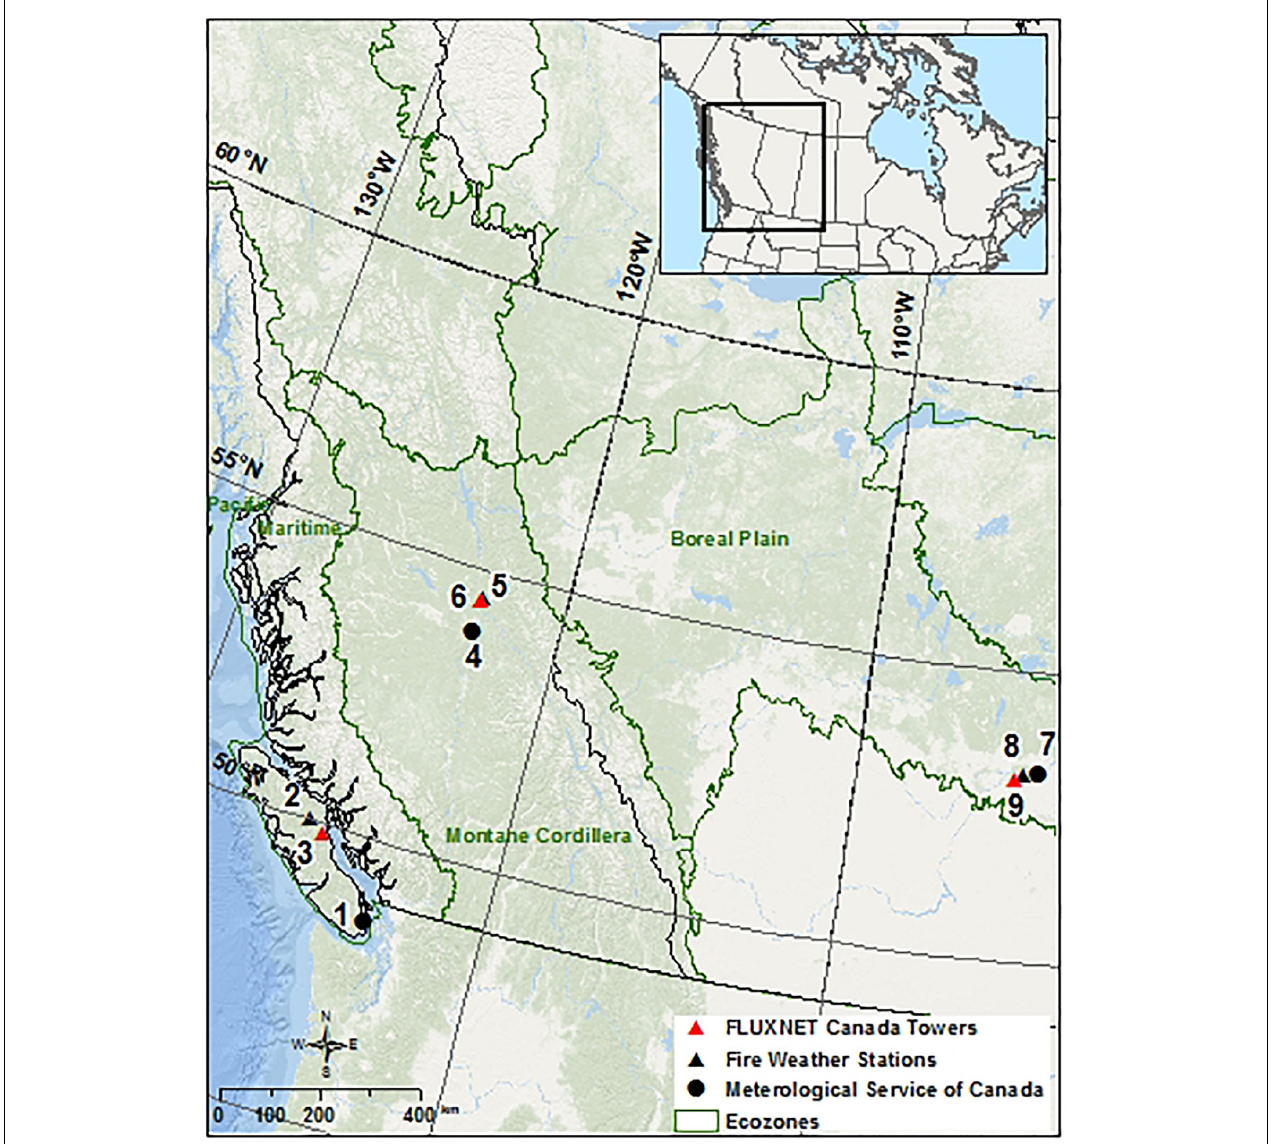
FIGURE 2 | Location of the 9 weather stations used in the spectral analysis of fire weather in the Pacific Maritime, Montane Cordillera, and Boreal Plain ecozones. Station names and details are in Table 2